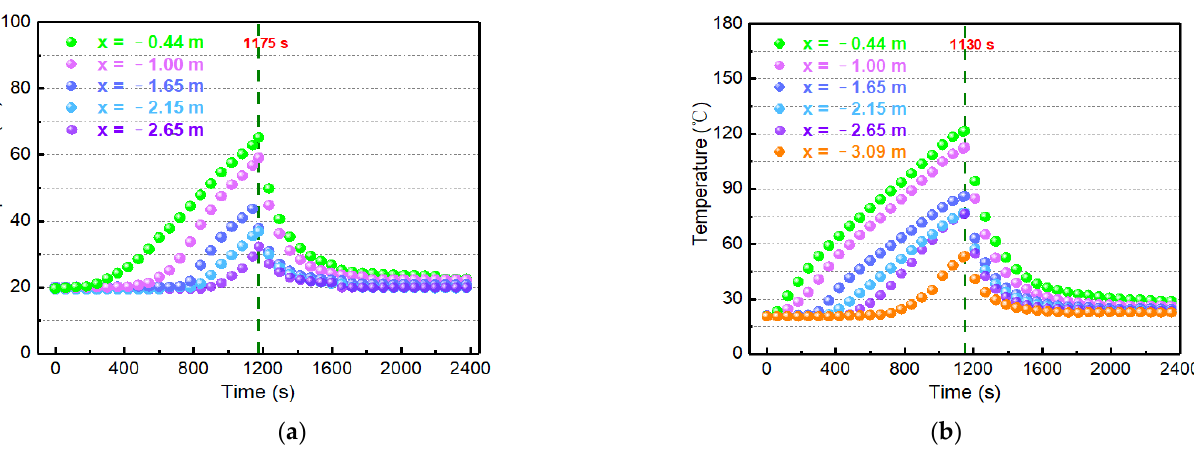
Figure 5. Temperature variation on the upstream of fire source for different schemes when the ven- tilation velocity is 1.40 m/s: ( a ) Air-door 5 closed. ( b ) Air-door 5 half closed. ventilation velocity is 1.40 m/s: ( a ) Air-door 5 closed. ( b ) Air-door 5 half